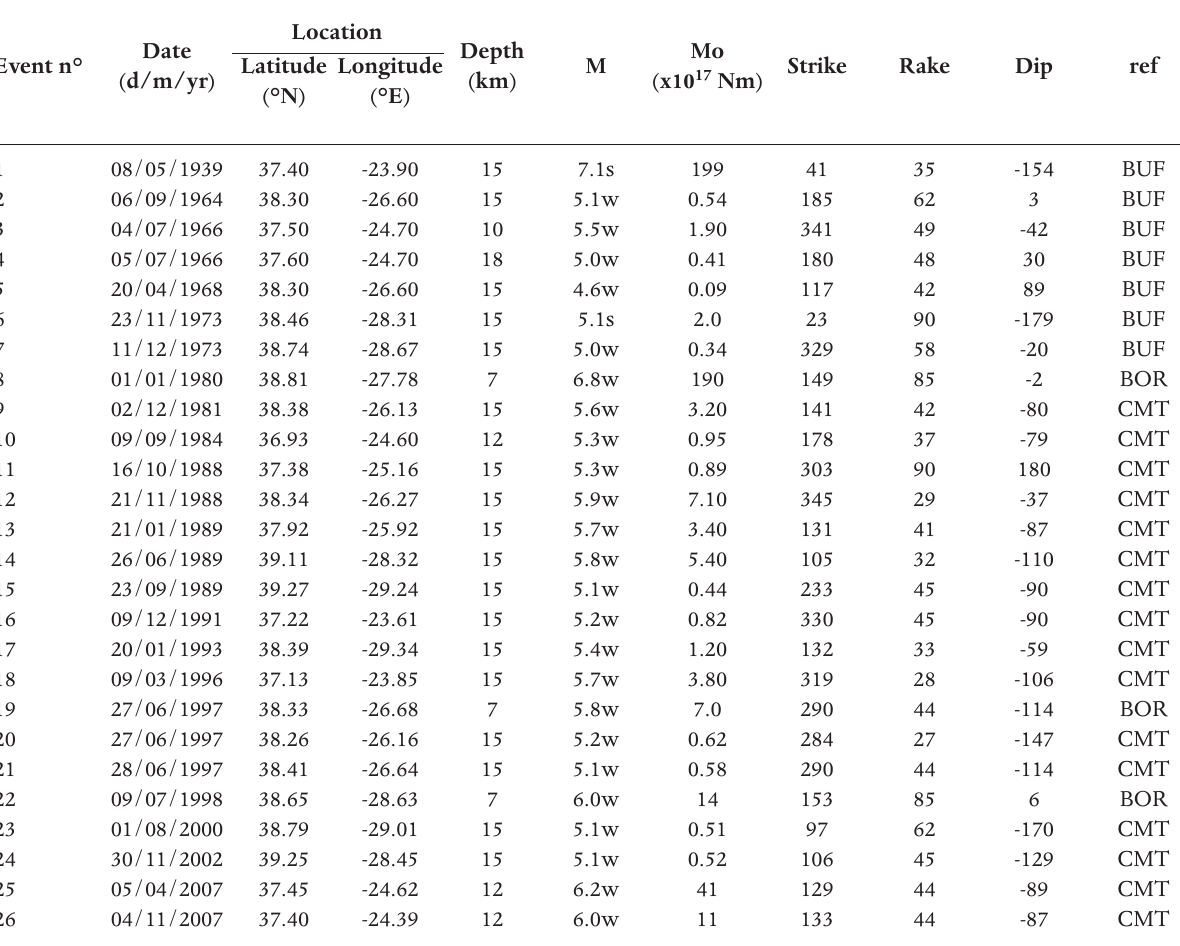
Table 1. Seismic events with published focal parameters for the Azores region (from 1900 to present). References: CMT: centroid-moment tensor, Havard in Borges et al. [2007, 2008], BUF: Buforn et al. [1988], BOR: Borges et al. [2007]. For the magnitude w and s indicate Mw e Ms, respectively [Borges et al. 2007, 2008].